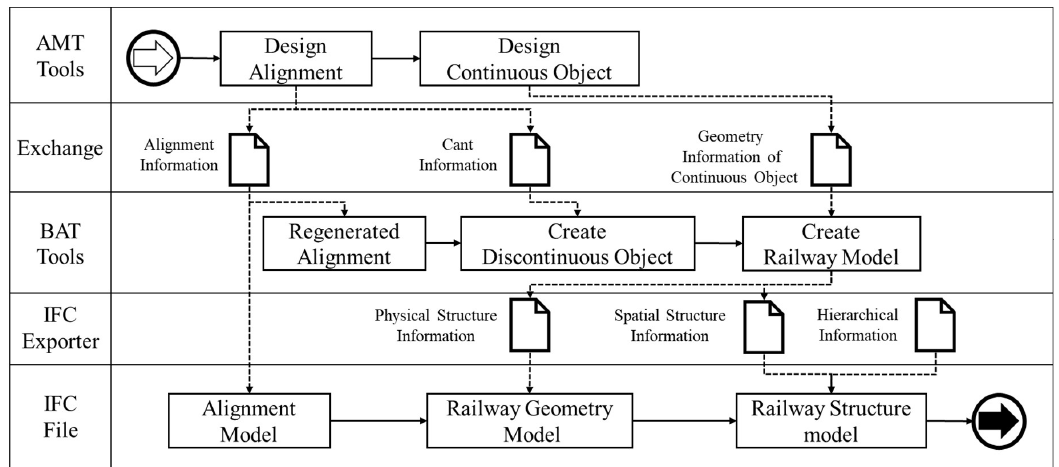
Figure 2. Process of railway track modeling using software linkage. AMT: Alignment-centered modeling